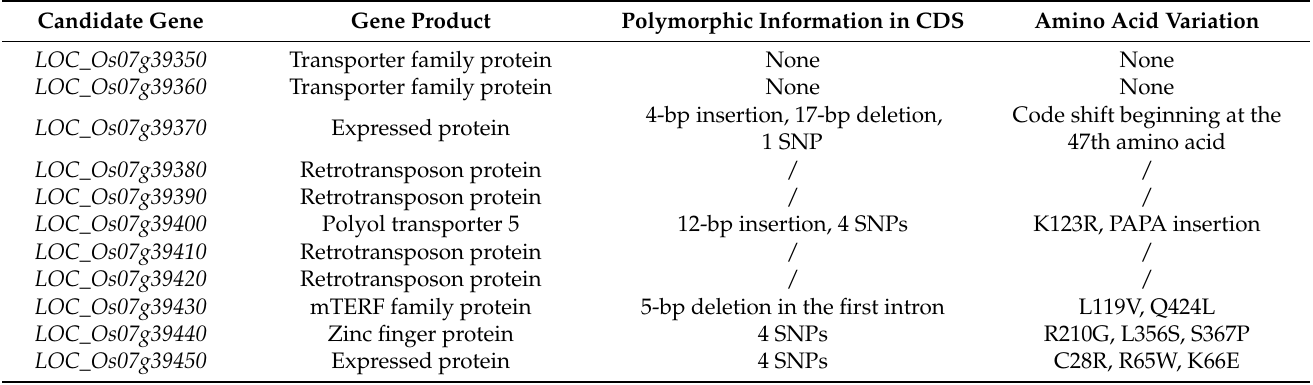
Table 7. Candidate genes in the target region of